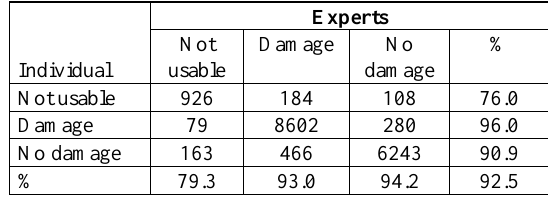
Table 1. Error matrix for agreement of individual volunteer ratings with the expert classification for images in the